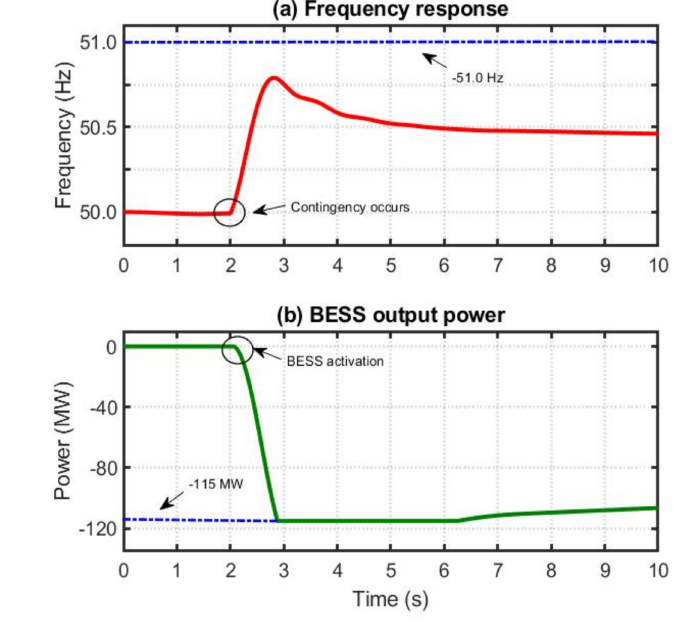
Figure 9. Frequency responses and BESS output due to 400-MW interconnection trip in four-machine